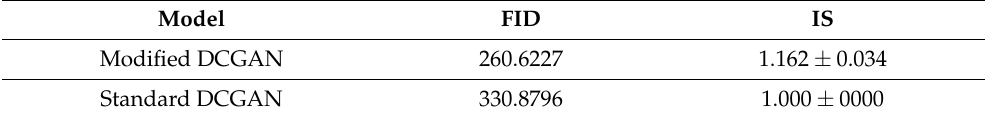
Table 5. Comparison between modified and standard DCGAN on IS and FID Indicators.